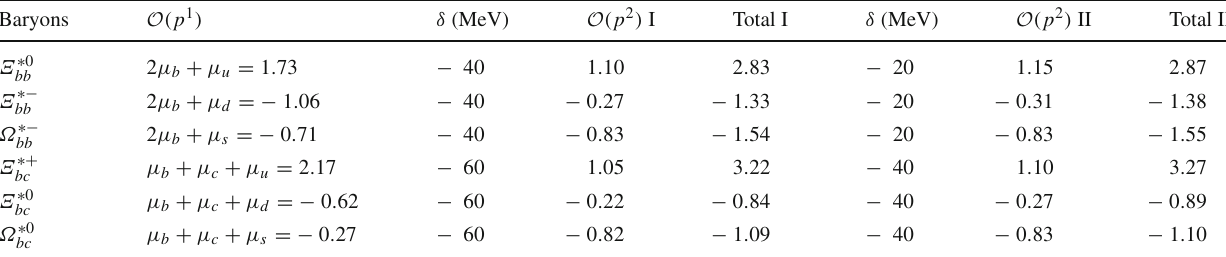
spin wave functions in the heavy quark sector. We adopt δ = − 40 and δ = − 20 MeV for the doubly bottom baryons and δ = − 60 and δ − 20 MeV for the charmed bottom